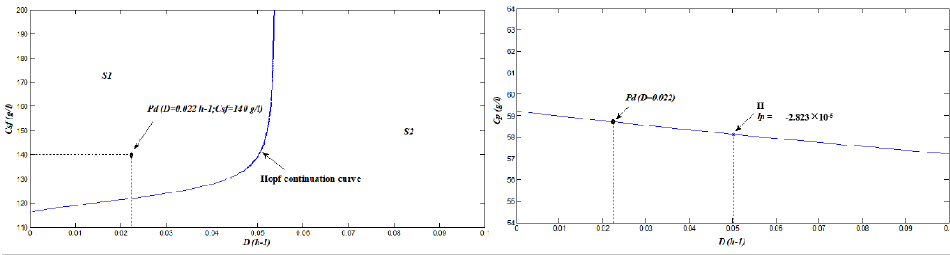
Figure 5. Bifurcation analyses on the ethanol fermentation process: two-parameter continuation diagram ( left ); and one-parameter continuation diagram ( right